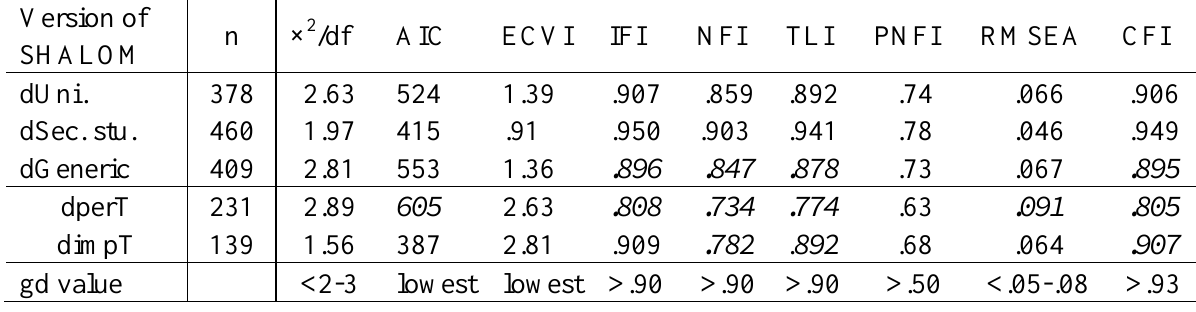
Table 4. Summary of CFA for dissonance values in versions of